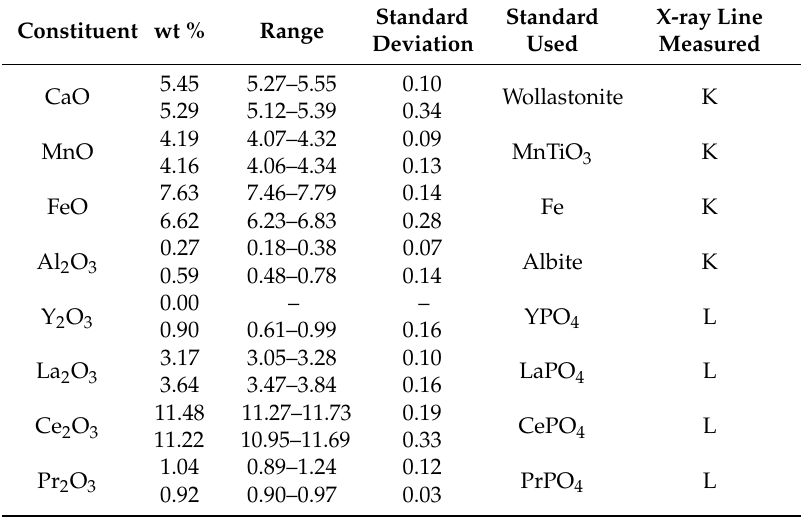
Table 3. Chemical data for nöggerathite-(Ce). Upper and lower values for each constituent correspond to the holotype and the cotype,